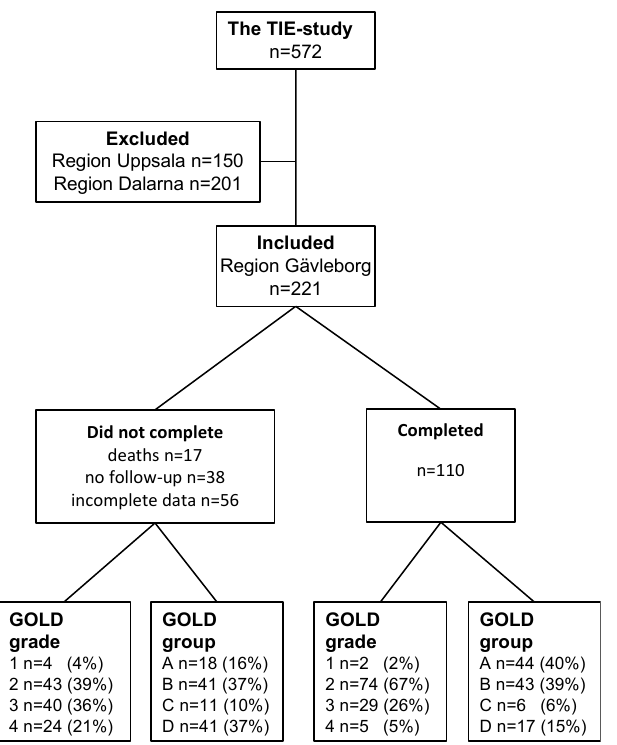
Figure 1. Flow chart of excluded and included COPD subjects. Subjects were grouped according to whether they completed or did not complete the study. Further grouping at inclusion was according to the GOLD 2021 assessment of airflow limitations (GOLD grade) and symptom/risk of exacerbation (GOLD group) (https://goldcopd.org, accessed on 1 March